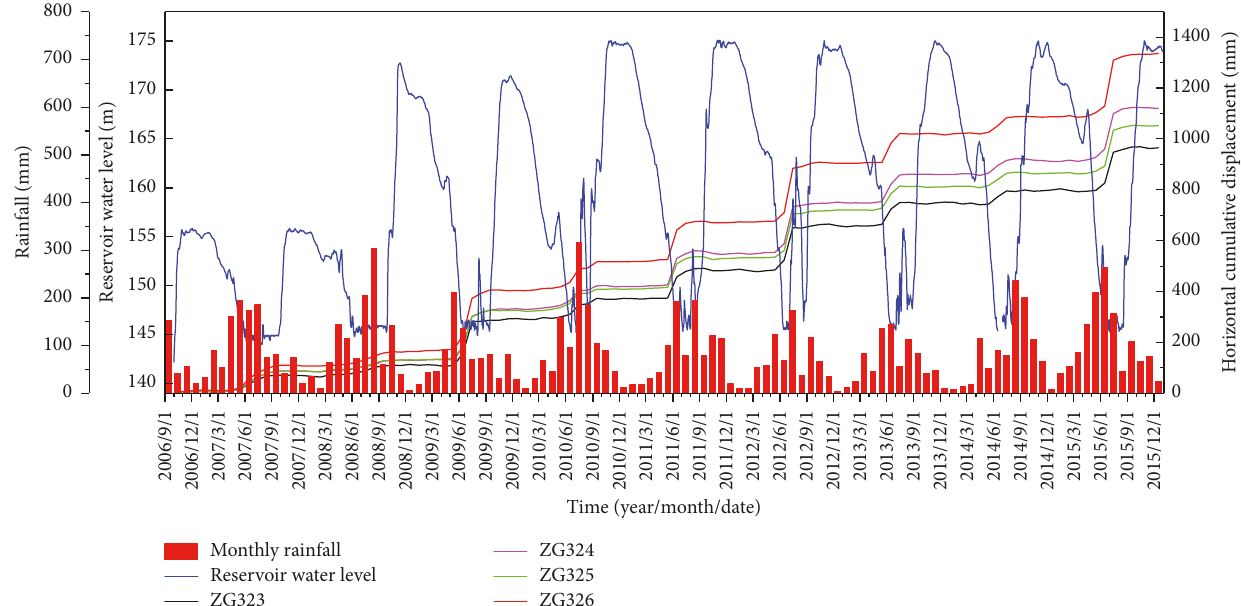
Figure 4: Monitoring curve of horizontal cumulative displacement at the ground of the landslide, with the monthly rainfall and reservoir water level.